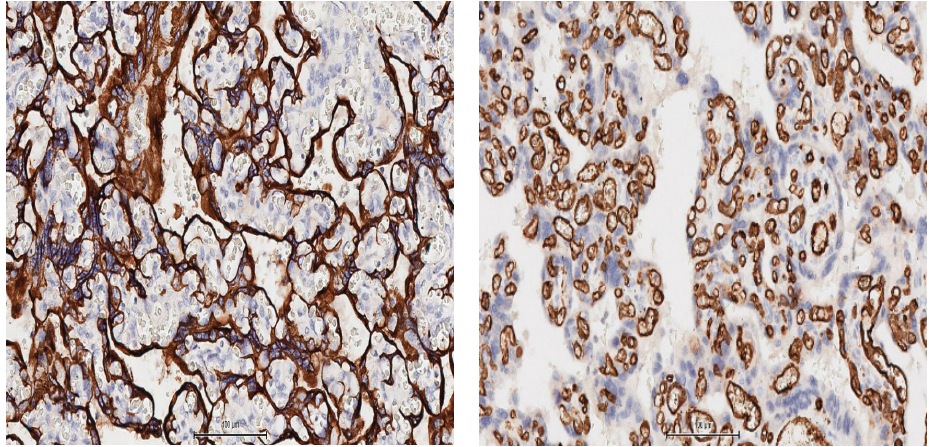
Figure 2. Histological modifications of the miometrium in a patient with SARS-CoV-2: ( A ) microphotography (4×) of the miometrium with diffuse oedema predominantly located in the perivascular areas; ( B – D ) interstitial blood suffusion as well as marked difference in celular coloration due to cellular oedema.